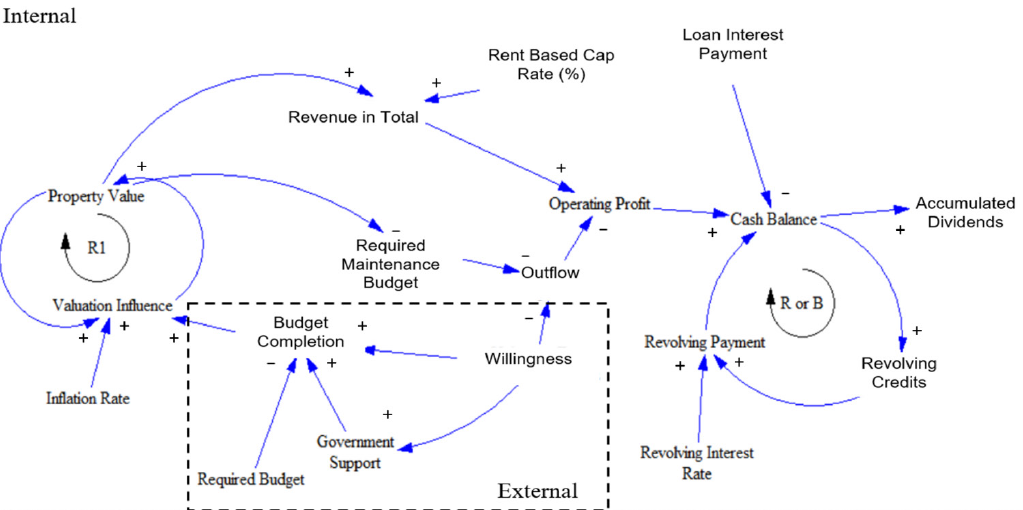
Figure 4. Feedback